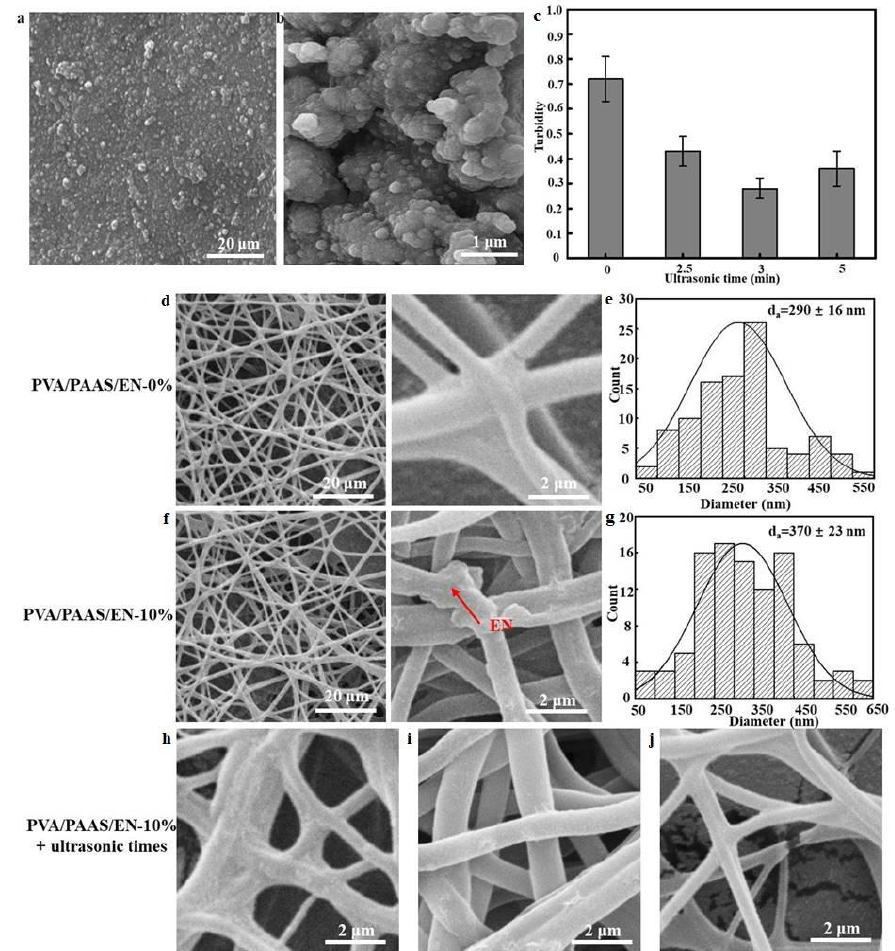
Figure 2. ( a ) SEM image of encapsulated nisin (pH 4.2, ultrasonication time 3.0 min, and E 1 /E 2 1.57), ( b ) magnified images of encapsulated nisin; ( c ) The effects of ultrasonication time on turbidity; ( d ) Typical SEM images of PVA/PAAS/EN-0%; ( e ) nanofiber diameter distribution histogram of PVA/PAAS/EN-0%;( f ) SEM images of PVA/PAAS/EN-10%; ( g ) nanofiber diameter distribution histogram of PVA/PAAS/EN-10%; ( h ) typical SEM 50000x images of PVA/PAAS/EN-10% nanofibers under ultrasound time 0 min; ( i ) ultrasound time: 15 min; ( j ) ultrasound time: 30 min.